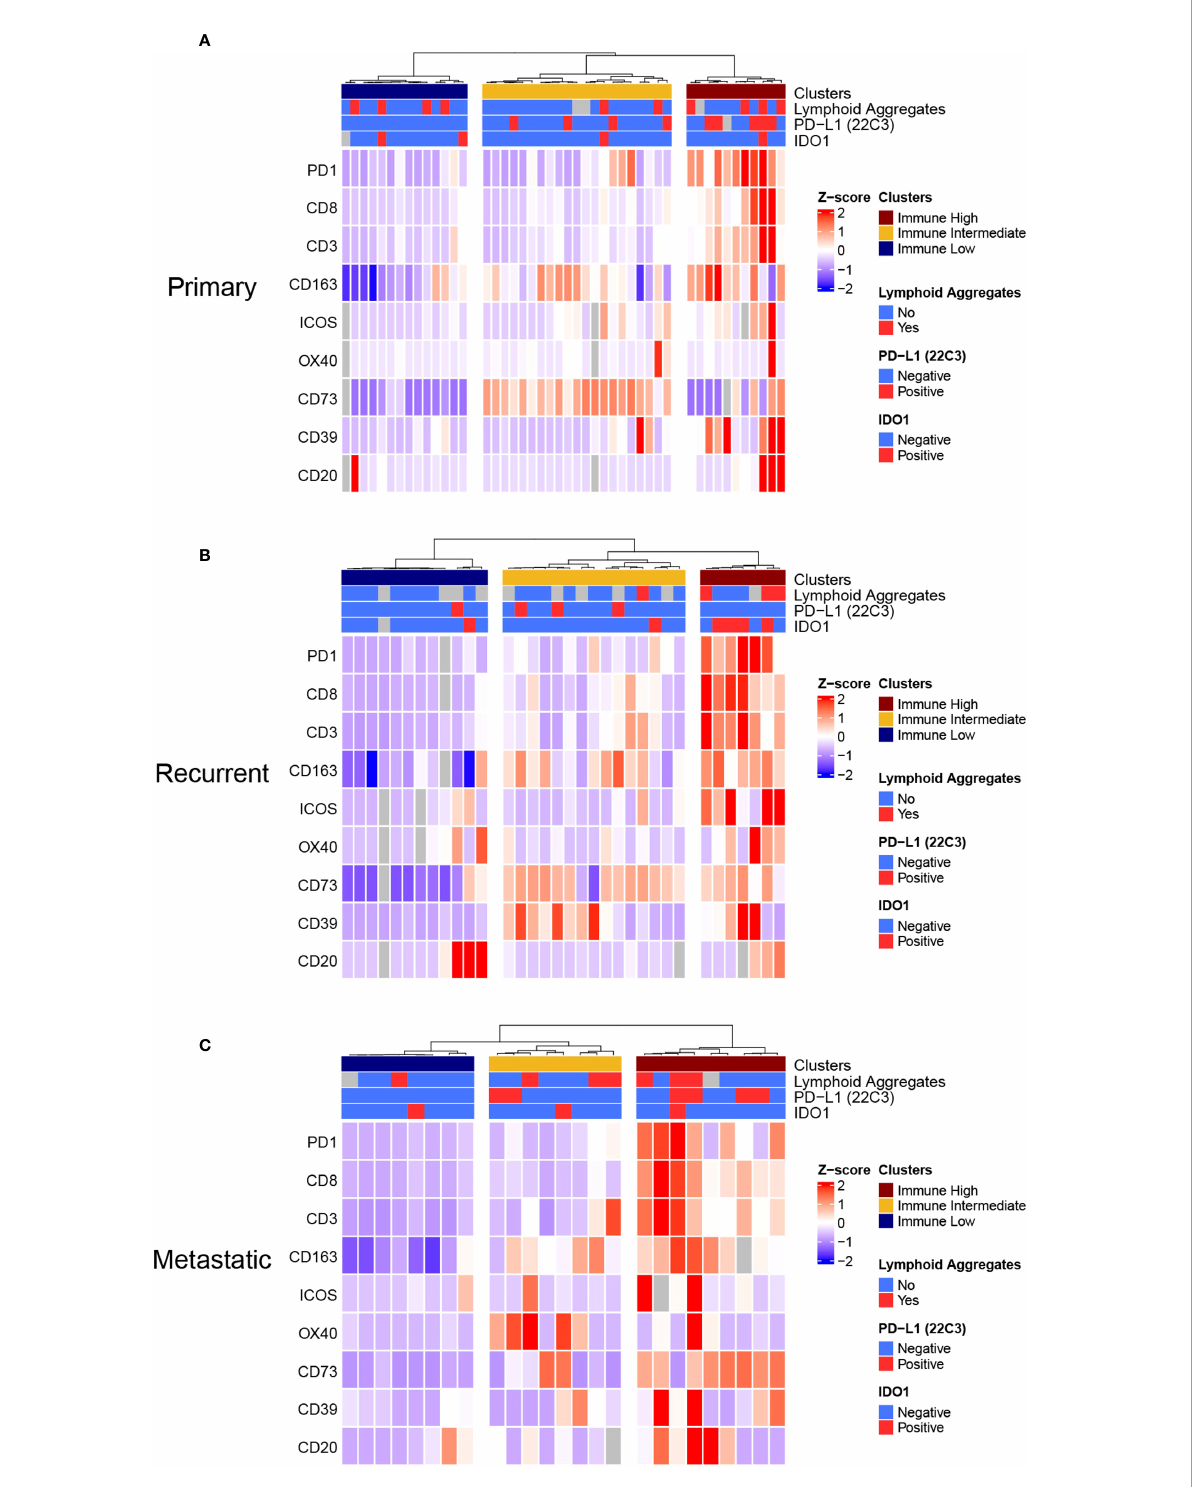
FIGURE 3 Unsupervised Hierarchical Clustering Heatmaps of (A) Primary, (B) Recurrent, and (C) Metastatic UPS displays Three Distinctive Immune Clusters. (A) , Primary, (B) recurrent and (C) metastatic UPS samples were clustered in three distinctive clusters: Immune Low, Immune Intermediate, and Immune High clusters. This analysis was done by unsupervised Ward-linkage hierarchical clustering based on Pearson correlation coef fi